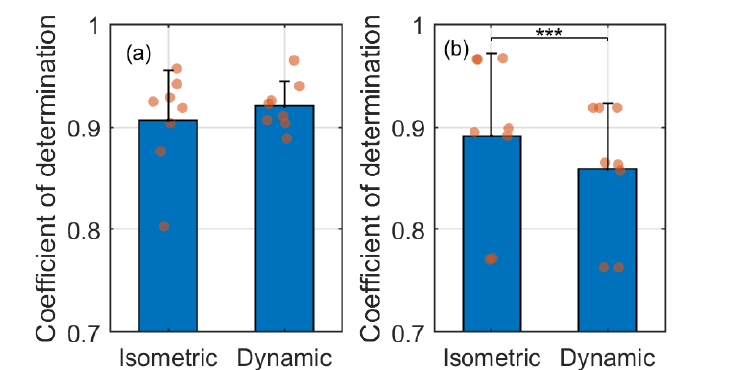
Figure 7. The comparison results of the coefficients of determination under isometric and dynamic conditions. ( a ) Exponential regression model between the dorsiflexion torque/angle normalization and muscle contraction cycles, ( b ) Exponential regression model between the ERC normalization and muscle contraction cycles. *** represents the significant difference level of p <